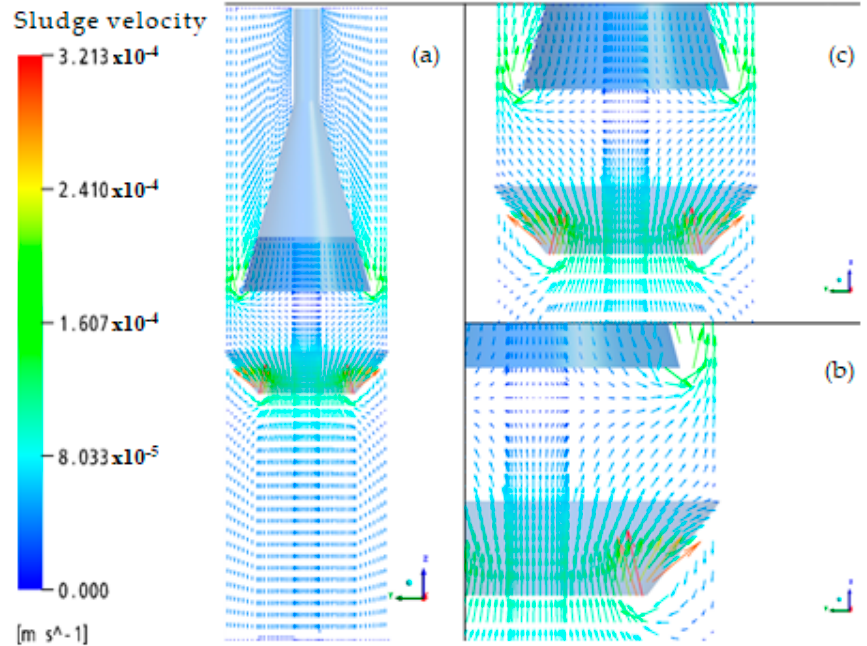
Figure 11. Sludge velocity vector in the reactor with deflector inclination downwards: ( a ) overview, ( b ) detail of the region between the gas deflector and the three-phase separating element, and ( c ) detail of the region corresponding to the settling zone.